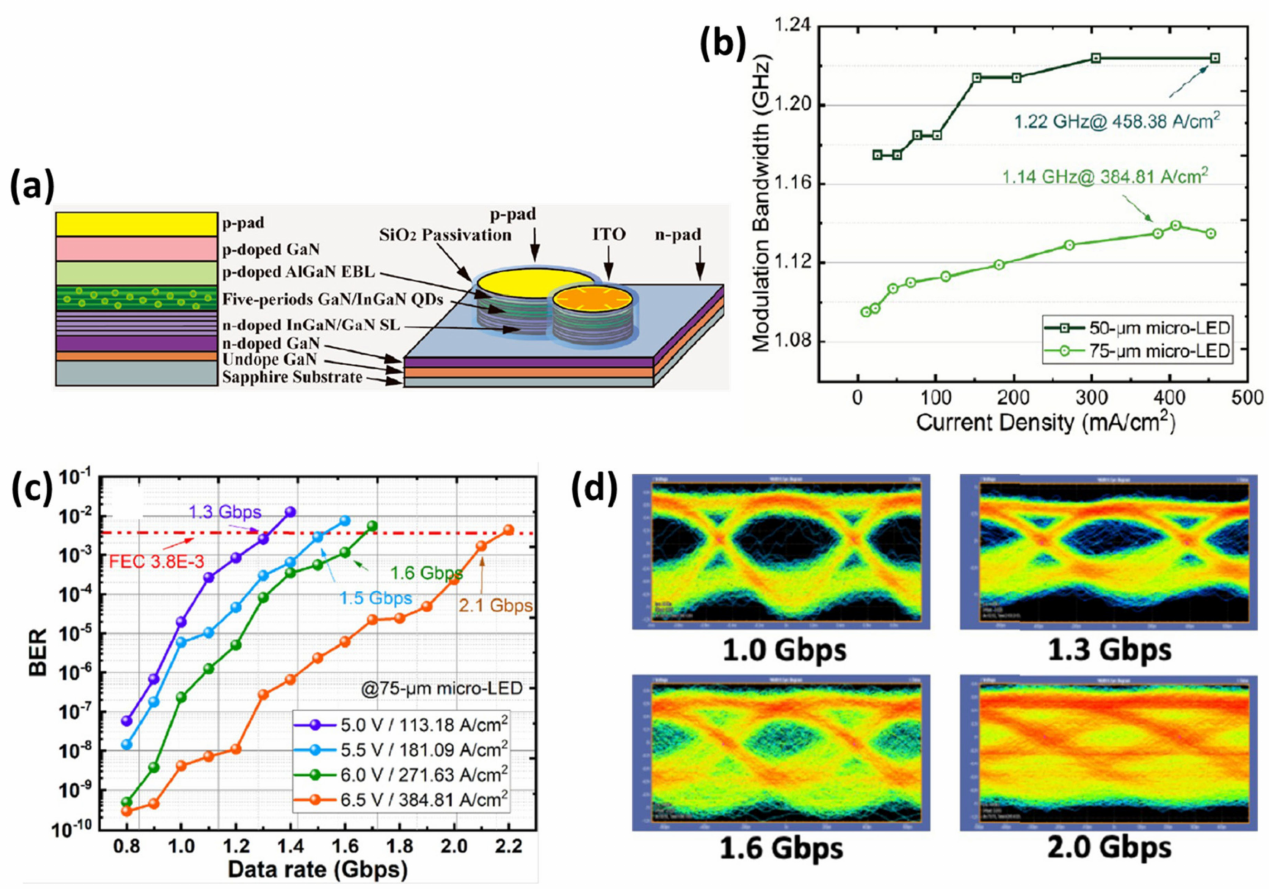
Figure 8. ( a ) Schematic diagram of epitaxial and single-pixel QD micro-LED structure. ( b ) Frequency responses of VLC systems based on 50 and 75- µ m green QD micro-LEDs. ( c ) BER performances and ( d ) Eye diagrams of real-time NRZ-OOK measurement. Ref. [64] Figures reproduced with permission from the American Chemical Soceity